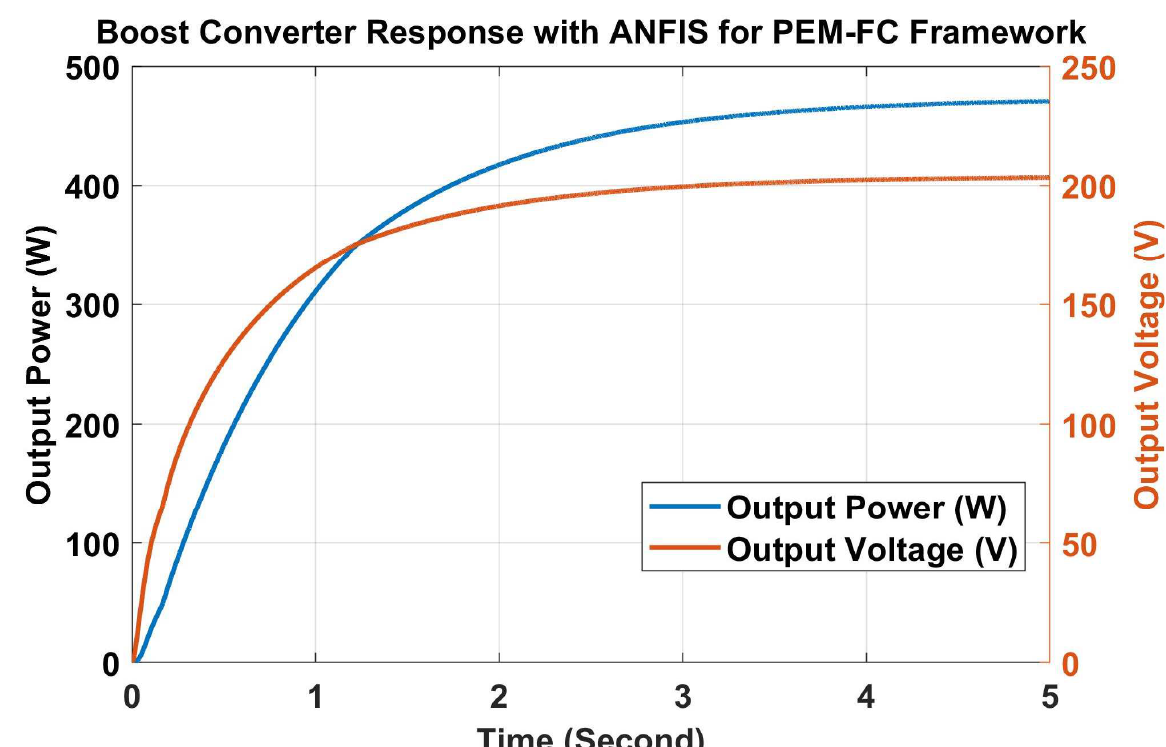
Figure 33. Output Power and Voltage of Boost Converter with AN-FIS MPPT for PEM-FC Frame- work.